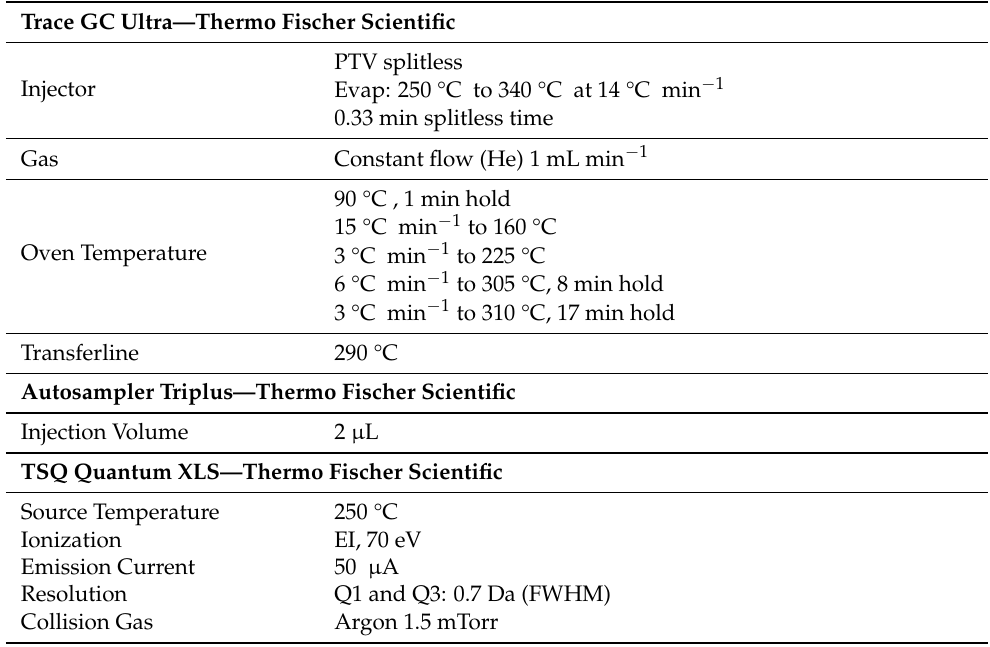
Table 1. Optimized chromatographic conditions for POP in Sardinella brasilienses muscle tissue